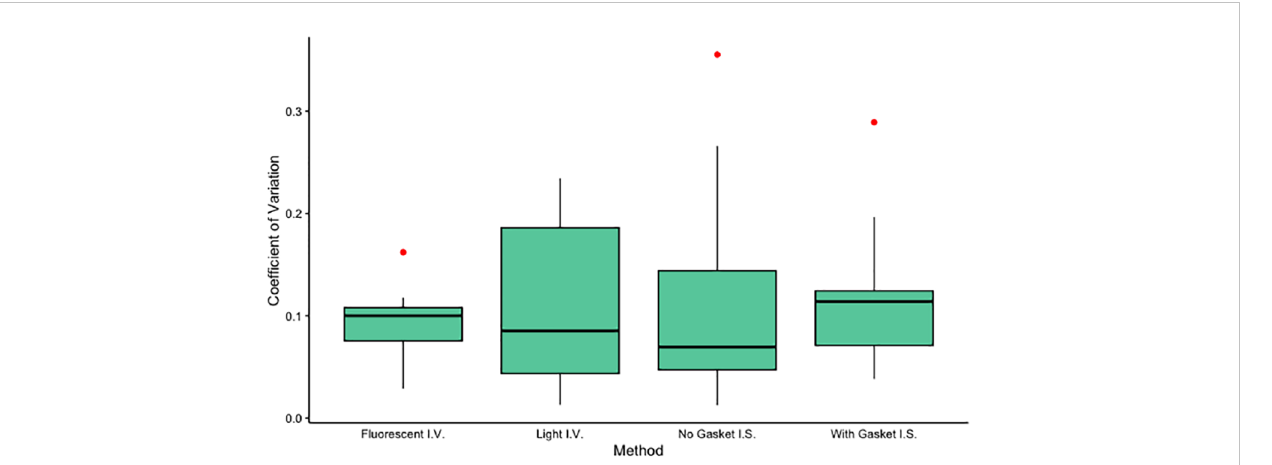
FIGURE 3 Coef fi cients of variation for each method tested (n = 10 each). Algal density of one anemone from each of 10 different clone lines was determined in triplicate using each of four methods: an in vitro method using a hemocytometer visualized with fl uorescent microscopy, an in vitro method using a hemocytometer visualized with light microscopy, an in situ method using a slide-mounted tentacle visualized using a confocal microscope, and an in situ method using a tentacle mounted on a gasket slide visualized using a confocal microscope. Mean CVs did not differ signi fi cantly among groups (ANOVA, F 3,36 = 0.155, p = 0.93) or between pairs of in situ or in vitro methods (paired t-tests, t = 0.34, p = 0.74 and t = 0.05, p = 0.96 respectively). I.V., in vitro ; I.S., in situ